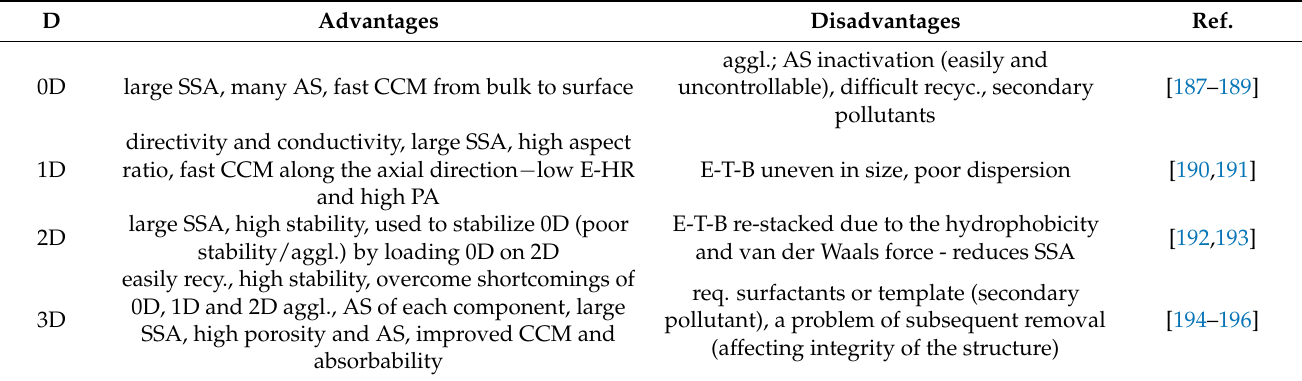
Table 6. Advantages and disadvantages of different